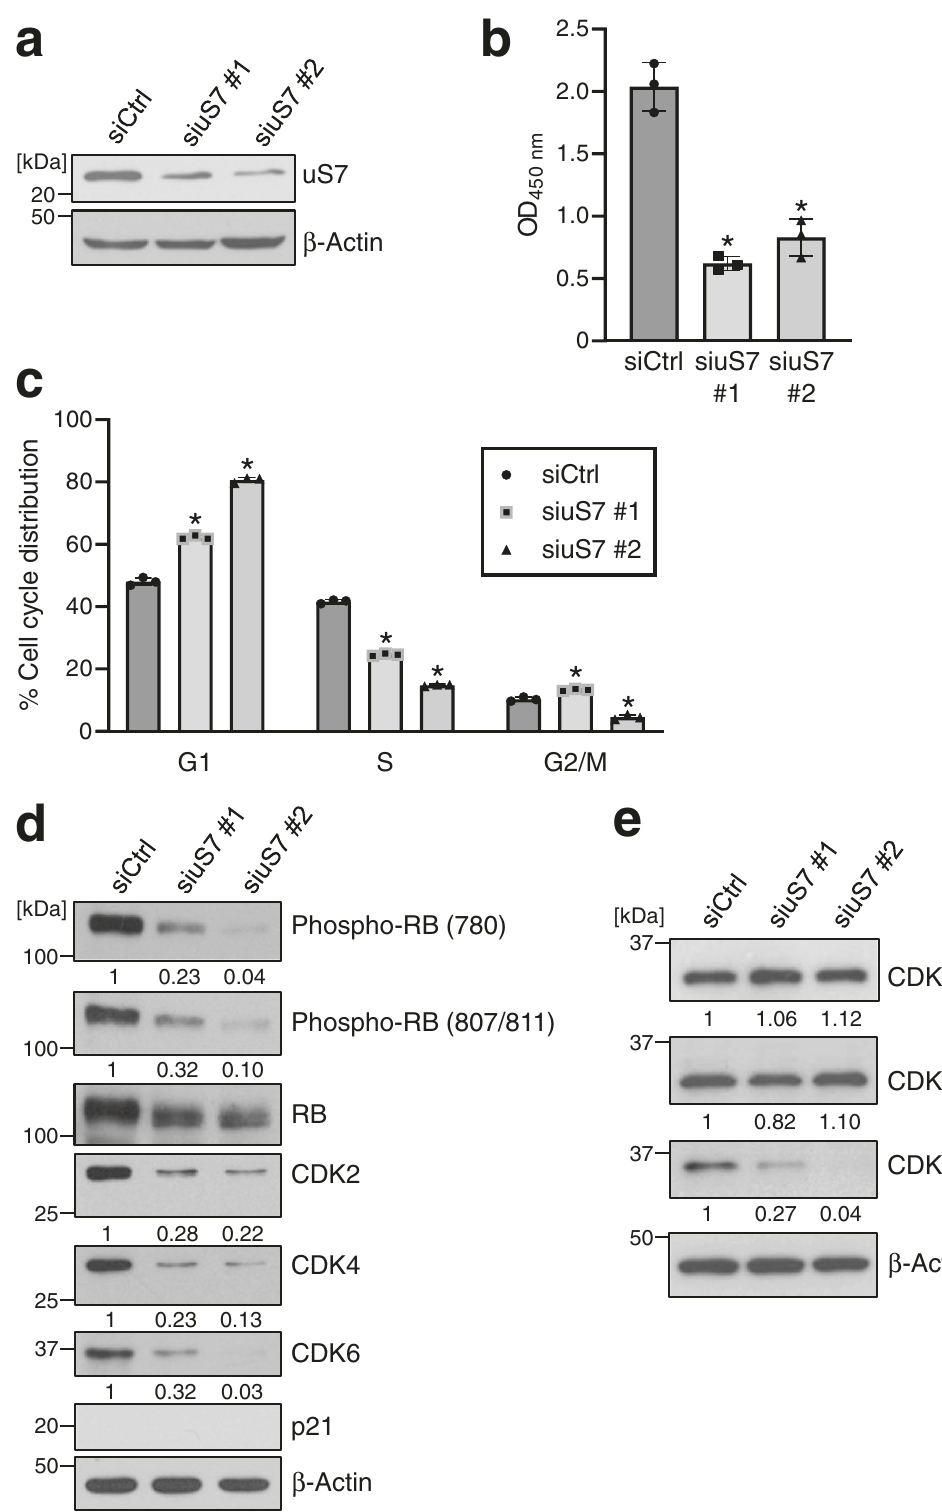
Fig. 4 The knockdown of uS7 reduces the CDK6 protein in colon cancer cell lines. a – d HT-29 cells were transfected with negative control siRNA (siCtrl) or two different siRNAs targeting uS7 (siuS7 #1 and #2). After 48 h, the depletion of uS7 was con fi rmed ( a ). After 72 h, cell proliferation was examined using the CCK-8 assay ( b ). After 48 h, the cell cycle was analyzed by fl ow cytometry ( c ), and protein levels were investigated by western blotting ( d ). e SW480 cells were transfected with each siRNA. After 48 h, cells were lysed and subjected to western blotting. In d , e , the signal of each western blot was quanti fi ed using ImageJ software and normalized by the value of β -actin. The value of each signal was indicated below the blot. Data are means ± S.D. ( n = 3 biologically independent experiments). * P < 0.05 signi fi cantly different from